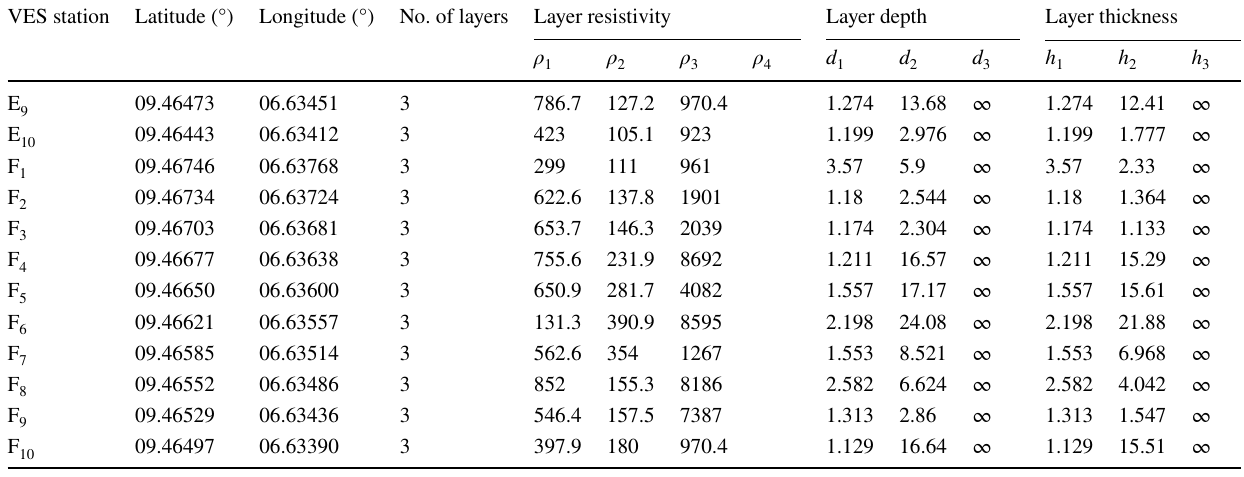
Fig. 3 Iso-resistivity contour map for the first